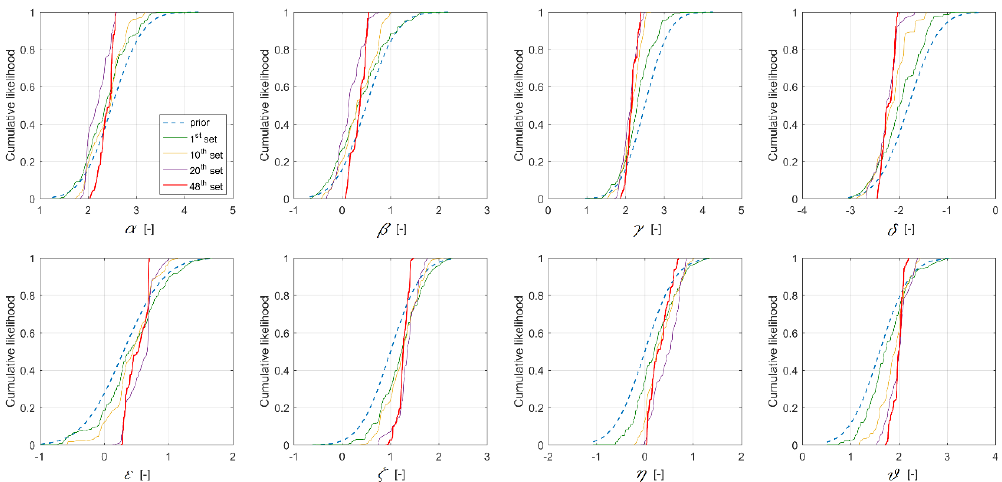
Figure 4. CDF of likelihood for the prior distribution and for a selection of simulation sets for each NDWI m parameter.